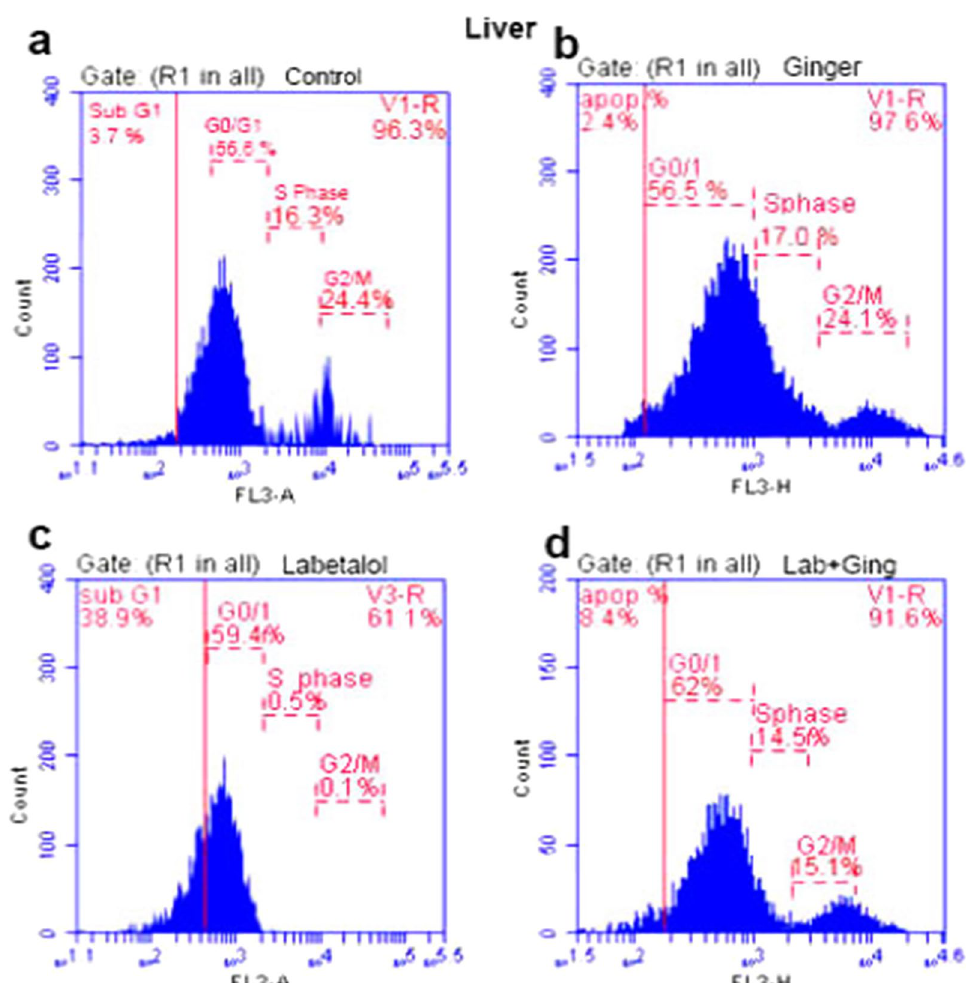
Fig. 5 Diagrams depicting the cell cycle distribution of hepatic cells from flow cytometry. a Control; b ginger; c labetalol; d labetalol